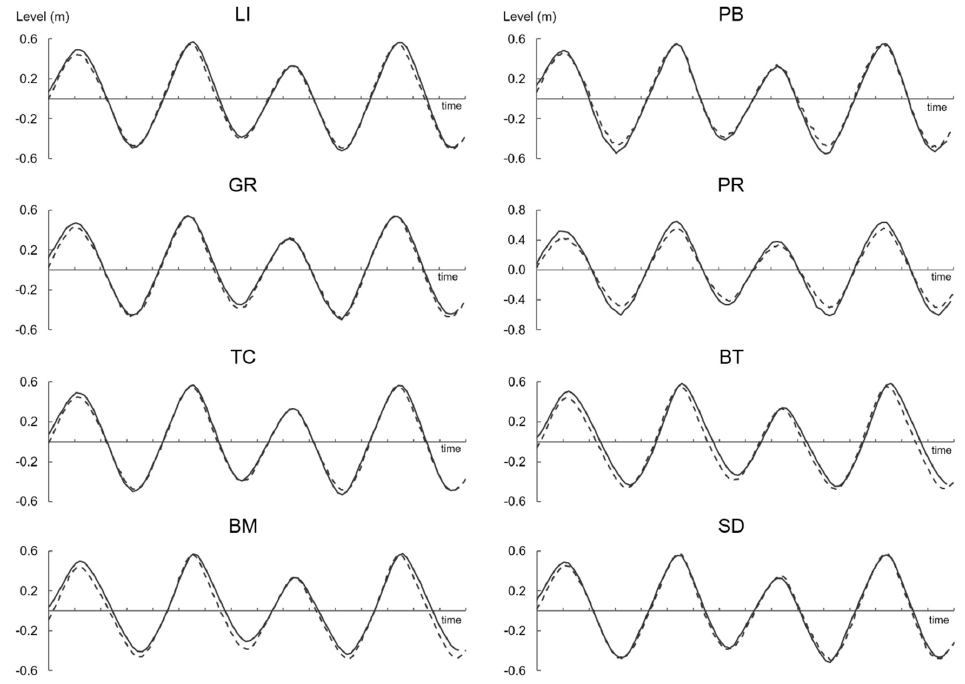
Figure 4. Calibration procedure: comparison of measured level (dashed line) and computed water levels at the stations (solid lines) in the period from 29 September 2014 to 3 October 2014.